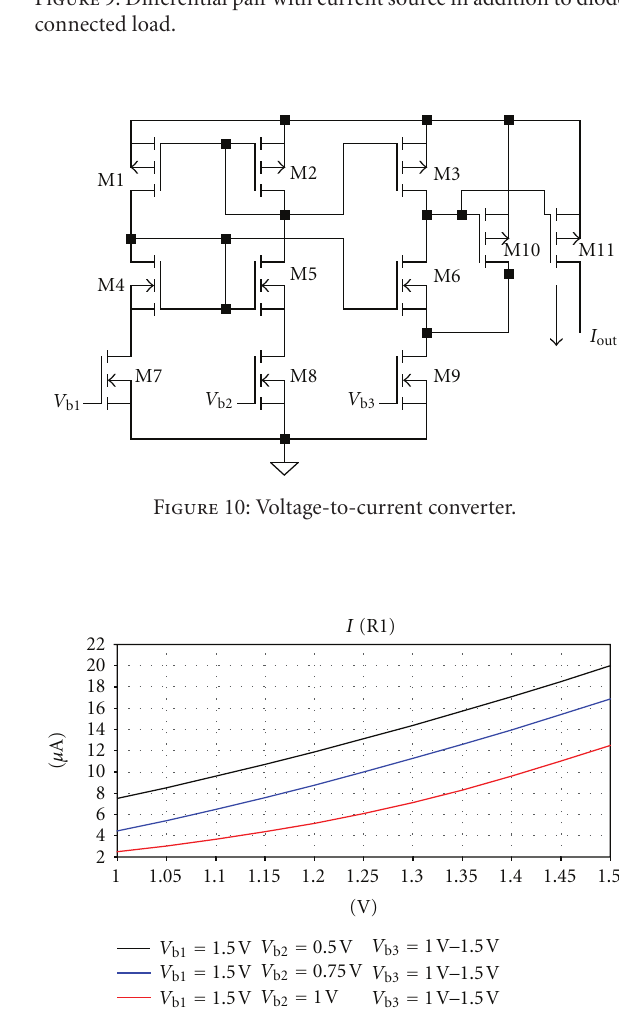
Figure 11: Voltage to Current converter output with V b1 = 1 . 5 V, V b2 = 0 . 5V, 0.75 V, and 1V, and V b3 sweep voltage from 1V to 1.5V in steps of